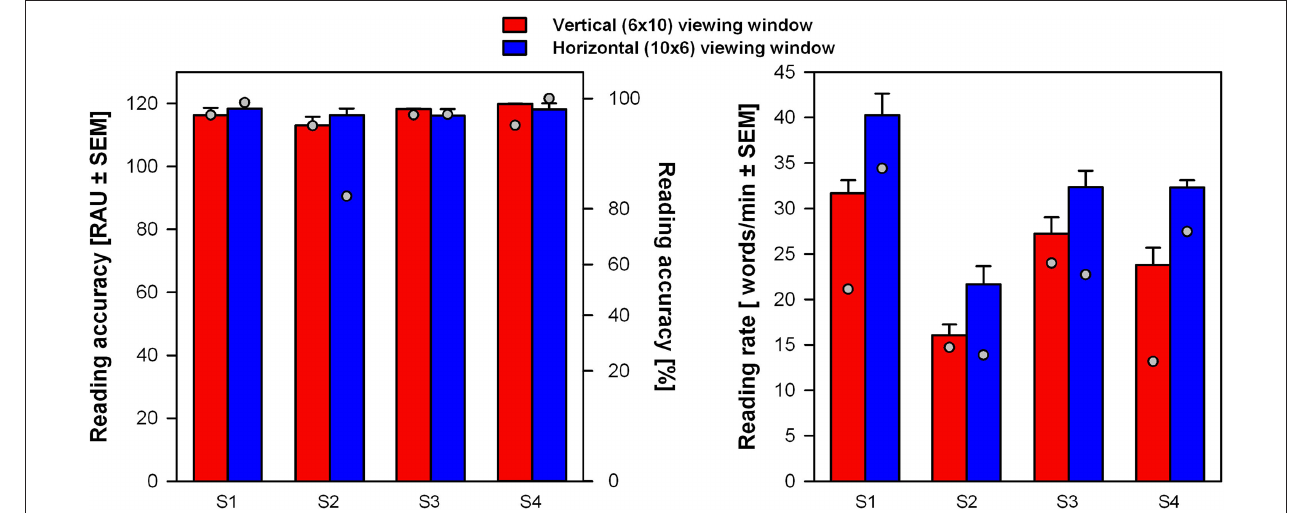
Figure 5 | reading performance measured at the end of the experiment using the “optimum” spatial resolution (4.5 pixels/char). Mean individual results for four subjects were calculated on the basis of three trials per condition. Results obtained with vertical (red bars) and horizontal (blue bars)